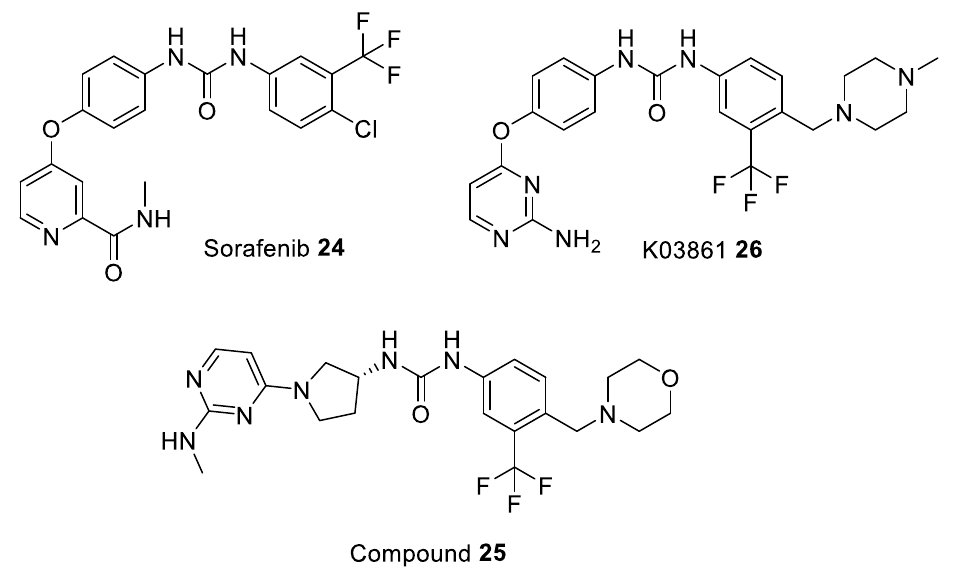
Figure 5. Chemical structures of some of the most studied type II CDK inhibitors.